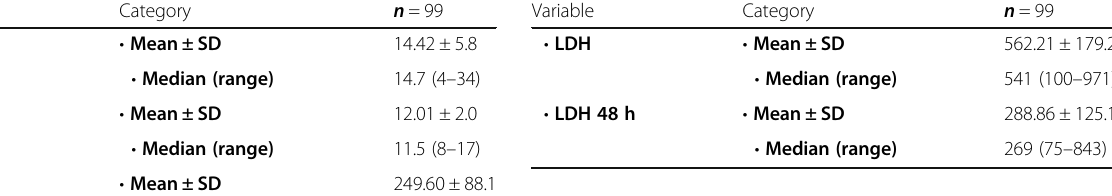
Table 1 CBC findings of the studied sample Variable Category